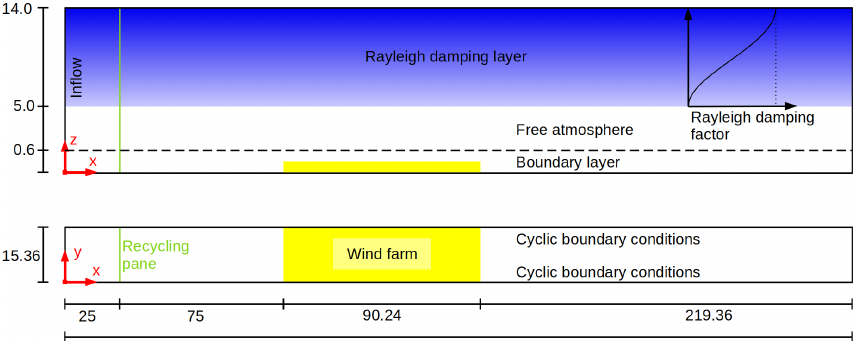
Figure 1. Side view and plan view of the domain and wind farm layout for the large wind farm case. Dimensions in kilometers.